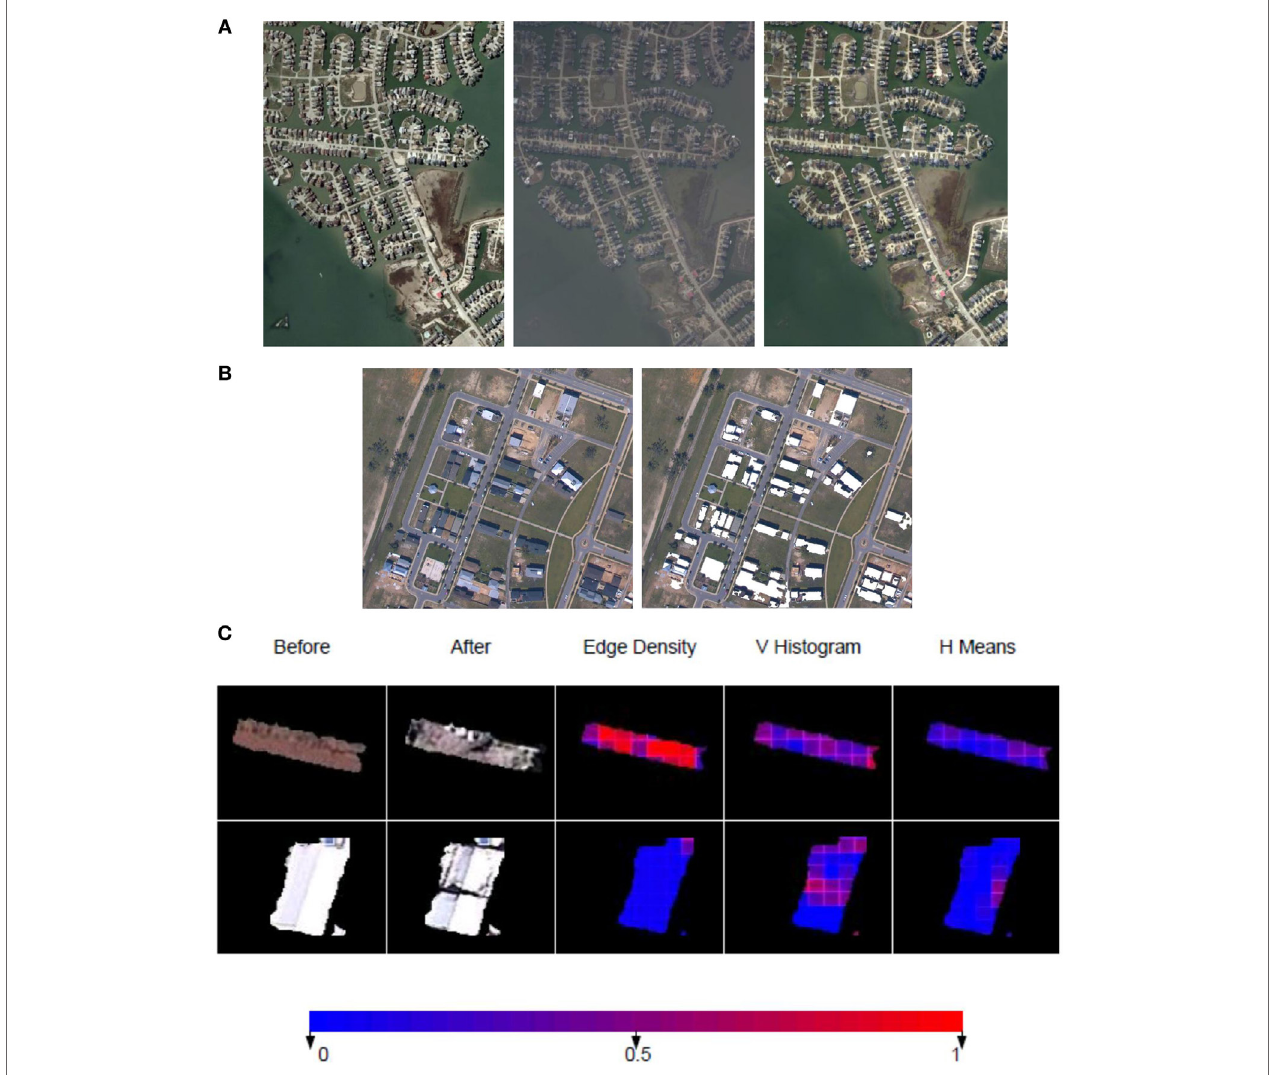
FigUre 13 | (a) Source images (left), Target images (middle) that have been corrected geometrically. New target image transformed using the proposed local color transfer technique (right). (B) Example of a satellite image (left) and extracted buildings in white (right). (c) Damage assessment: extracted features for a collapsed building (top) and a partially damaged building